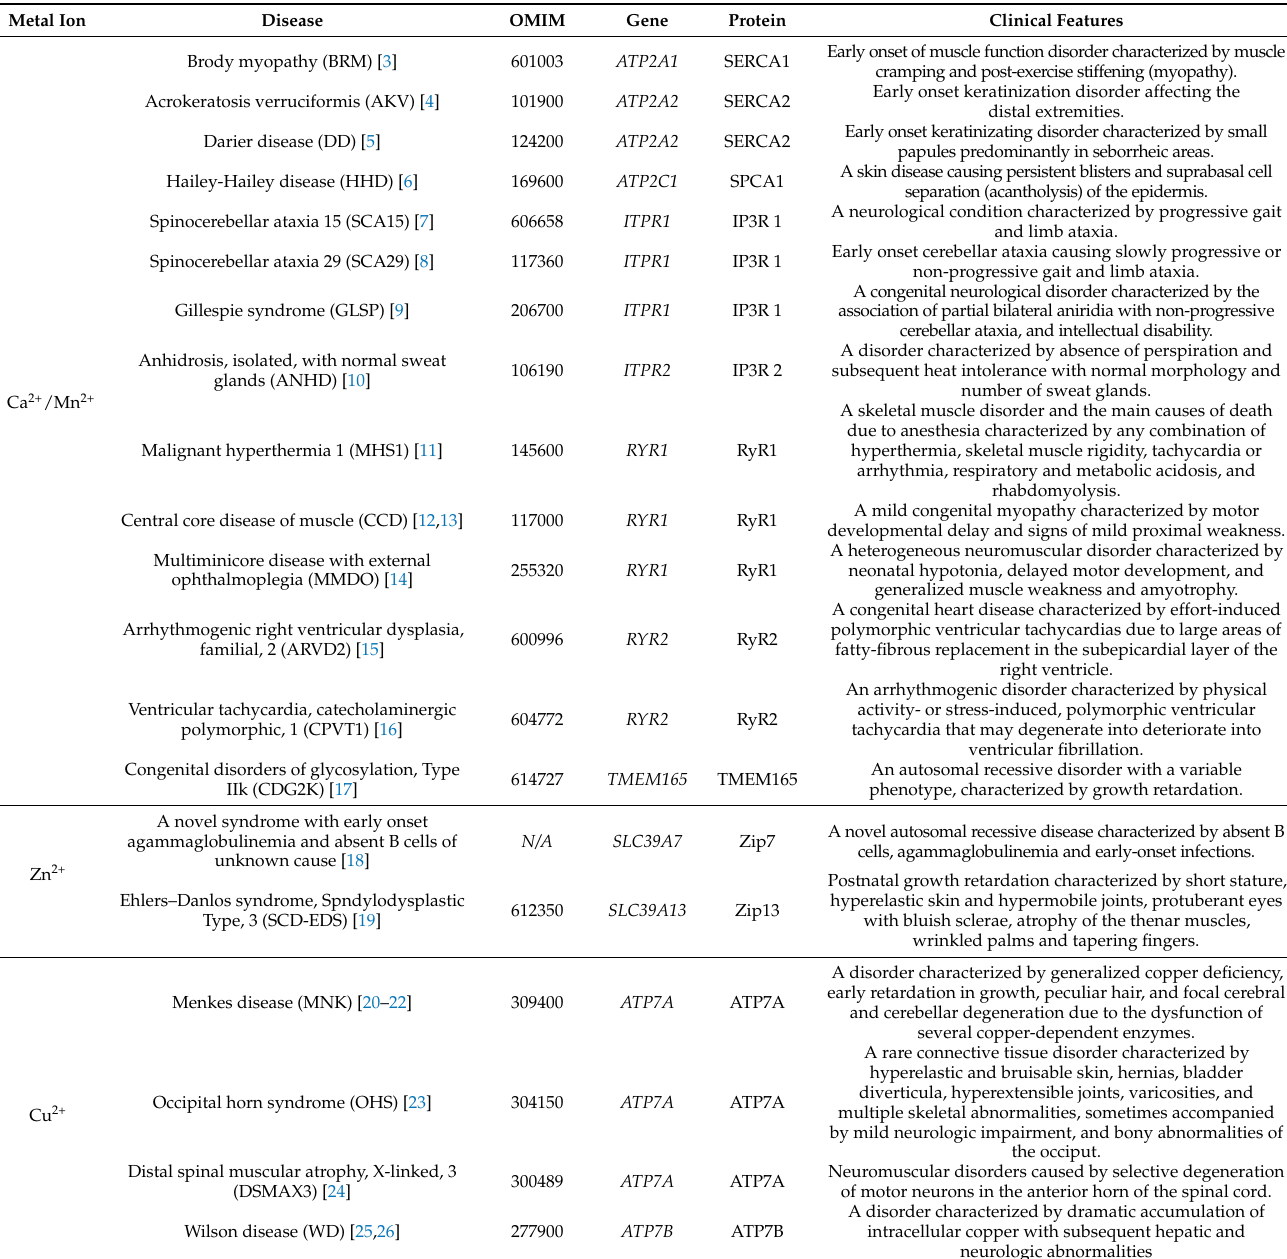
Table 1. Human diseases related to Golgi metal ion